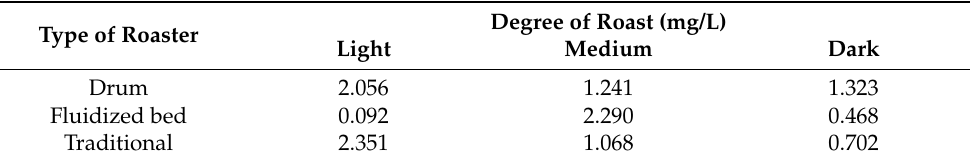
Table 5. Changes in acrylamide levels during various roasting process of the different degrees of roasting